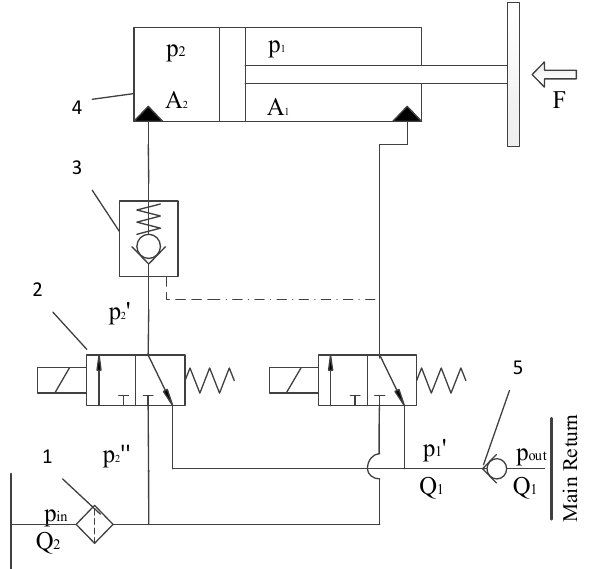
Figure 1. Schematic diagram of hydraulic system of hydraulic cylinder unit. 1. Filter. 2. Directional valve. 3. Liquid control check valve. 4. Hydraulic cylinder. 5. Return circuit